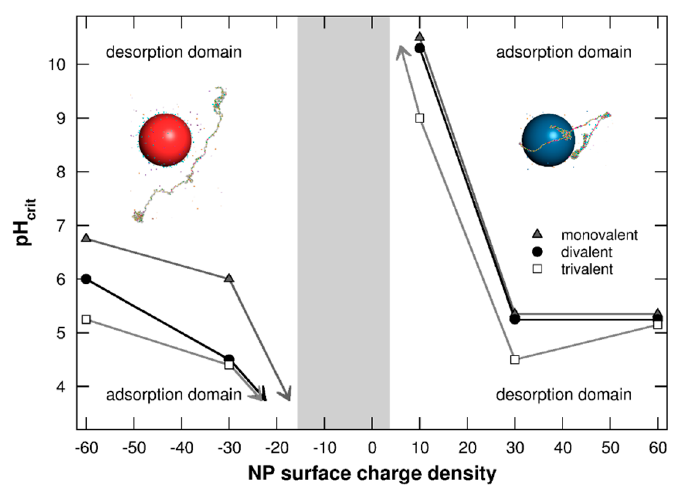
Figure 10. Adsorption/desorption limits pH crit of PP chain situated in the NP adsorption layer as a function of NP surface charge density ( σ = − 60 to +60 mC/m 2 ) in the presence of monovalent counterions. Red and blue spheres represent negative and positive NPs. Cases with monovalent, divalent, or trivalent salt cations are considered (ionic strength 1 × 10 − 4 M). Monovalent salt limit corresponds to the case without salt when NPs are negatively charged.